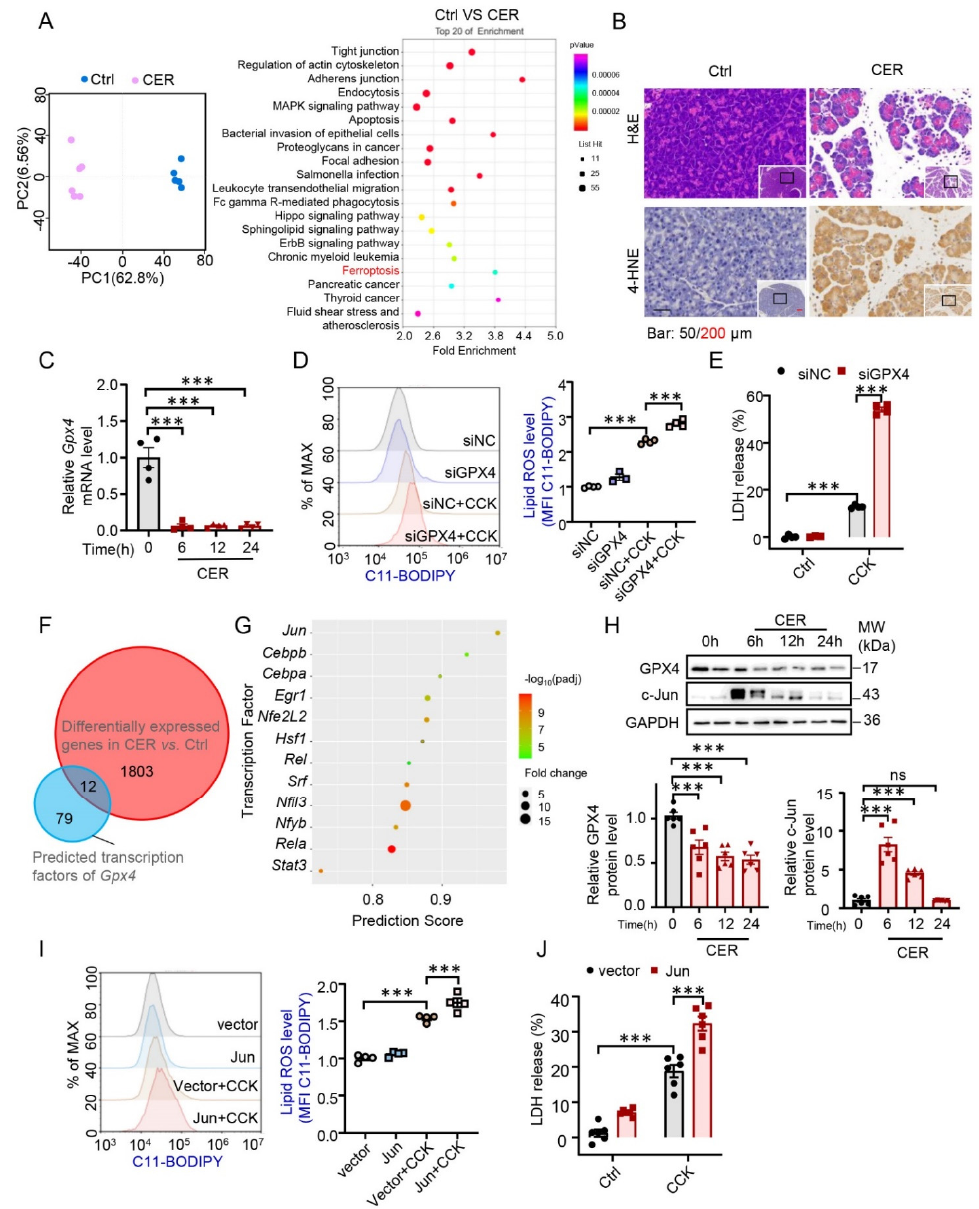
Figure 1. Acute pancreatitis (AP) progression was associated with glutathione peroxidase 4 (GPX4)- dependent ferroptosis and Jun elevation. ( A ) The principal component analysis and the enrichment analysis of Kyoto Encyclopedia of Genes and Genomes signaling pathways in cerulein (CER)- induced AP group compared with the control group from pancreas transcriptome data (GSE109227). ( B ) Representative photomicrographs of histopathology and 4-hydroxynonenal (4-HNE) using im- munohistochemistry (IHC) in the pancreas of mice (control [Ctrl] VS CER, n = 4). ( C ) The mRNA of GPX4 in the pancreas of CER-induced AP mice were measured using qPCR ( n = 4). ( D , E ) After transfection with GPX4 siRNA, the cells were treated with cholecystokinin (CCK) (5 µ M) for 6 h, and lipid reactive oxygen species (ROS) levels and the extent of cell death were determined ( n = 4). ( F ) Differently expressed genes in pancreas transcriptome analysis were overlapped with predicted transcription factors of GPX4. ( G ) Fold change and prediction score of selected transcription factors in CER group compared with control group. ( H ) The protein expression of GPX4 and Jun in the pancreas of CER-induced AP mice were measured using western blotting ( n = 6). ( I , J ) After transfected with plasmid of Jun for 36 h, the cells were treated with CCK (5 µ M) for 6 h, and lipid ROS levels and the extent of cell death were determined ( n = 4–6). ***, p < 0.001; ns, not